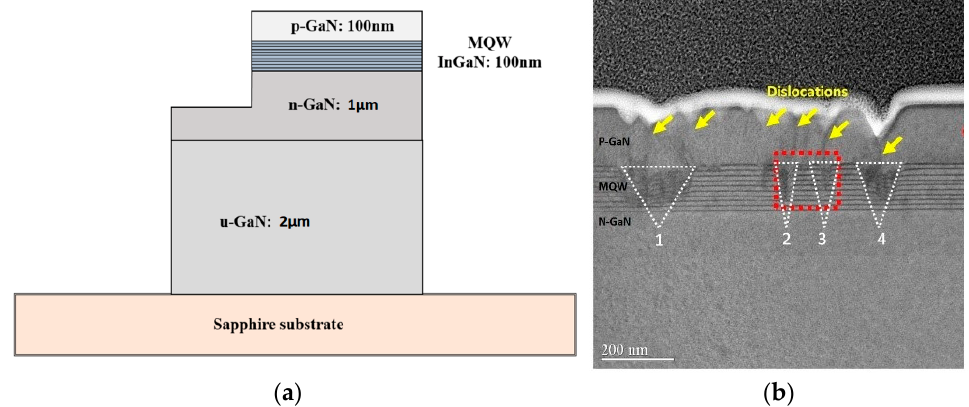
Figure 1. ( a ) InGaN/GaN Multi-Quantum Well (MQW) structure layers. ( b ) Scanning transmission electron microscopy (STEM) cross section along the (1120) zone axis showing dislocations.